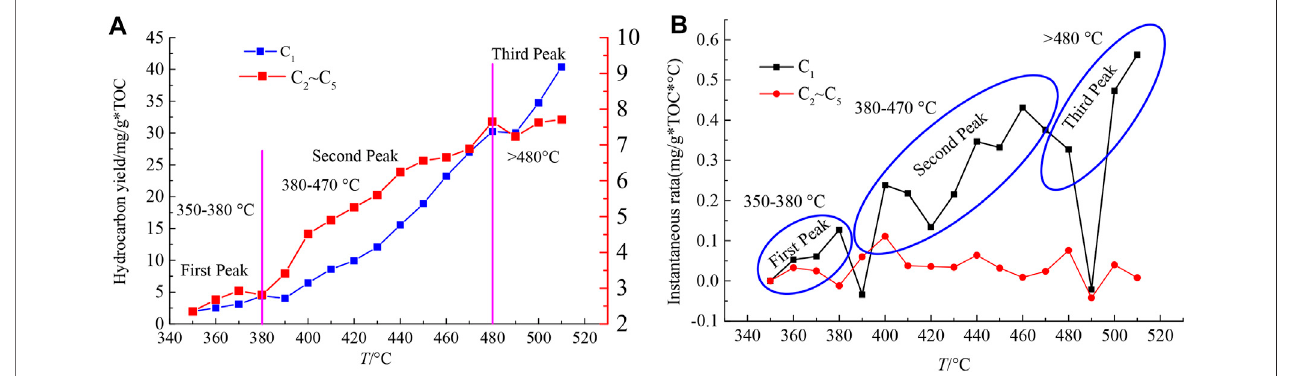
FIGURE 12 | (A) Hydrocarbon yield and (B) instantaneous rate under different pyrolysis temperatures (Song et al., 2017c).